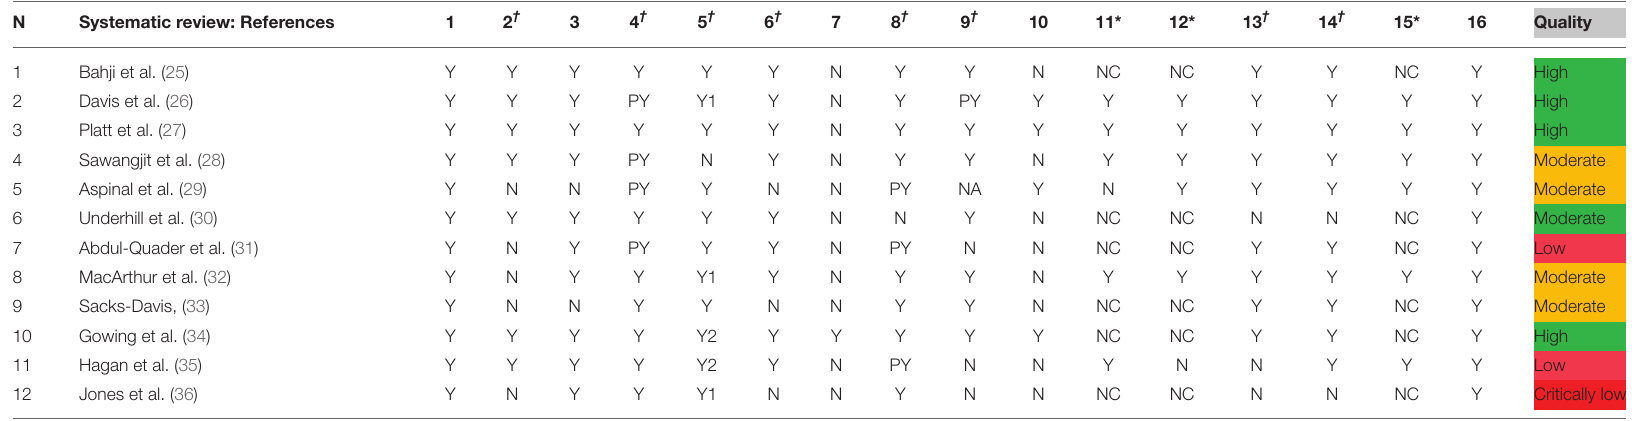
TABLE 1 | Evaluation quality of evidence of included SRs using